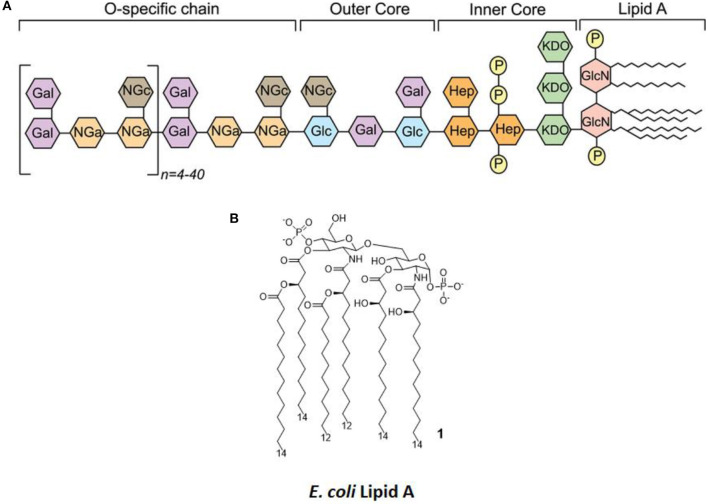
LPS Structure. (A) General structure, highlighting the different regions of LPS (O-antigen, core, and lipid A) and the various sugars composing it. (B) The molecular structure of Escherichia coli's lipid A.